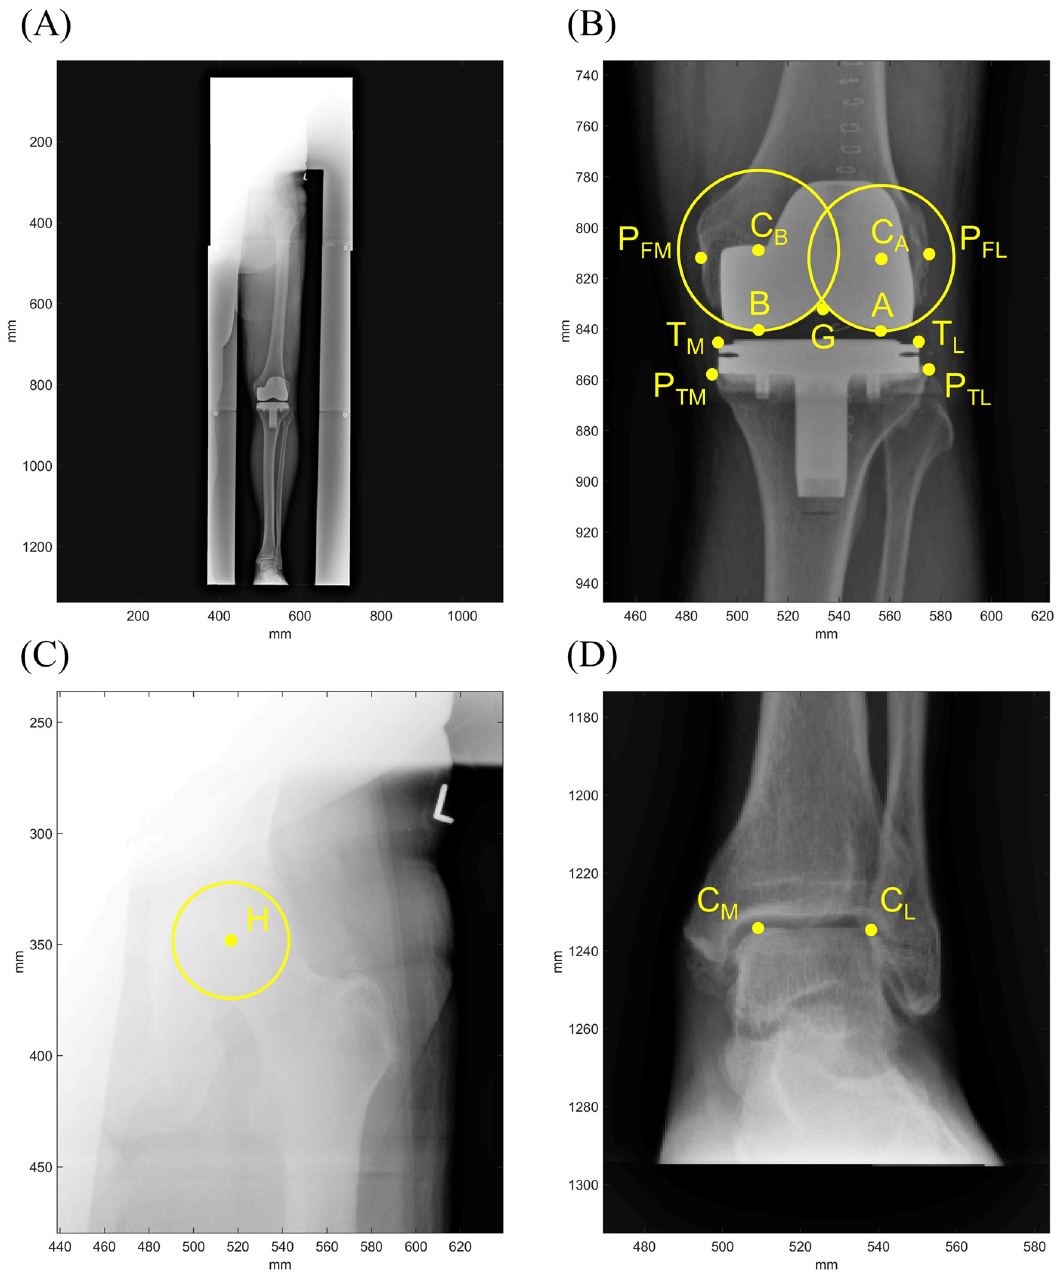
Fig 2. Parameter acquisition for patient-specific model adaptation (exemplary). (A) Long-leg radiograph, (B) knee region, (C) hip region, and (D) ankle region. The nomenclature is presented in Table 3.